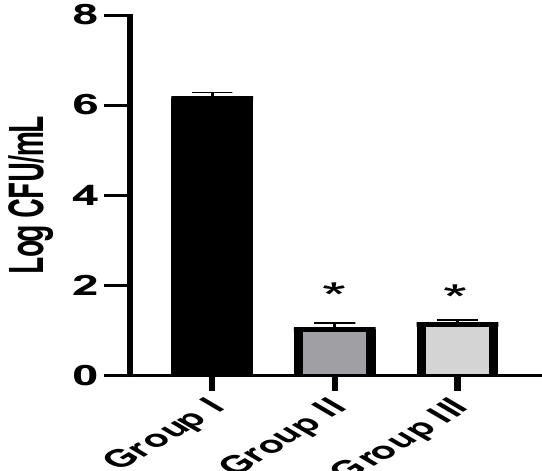
Figure 6. The number of colony-forming units per gram (CFU/g) of fungal cells in kidneys of the three groups. The symbol (*) represents a substantial decrease ( p < 0.05). There was a non-significant difference between group II and group III.